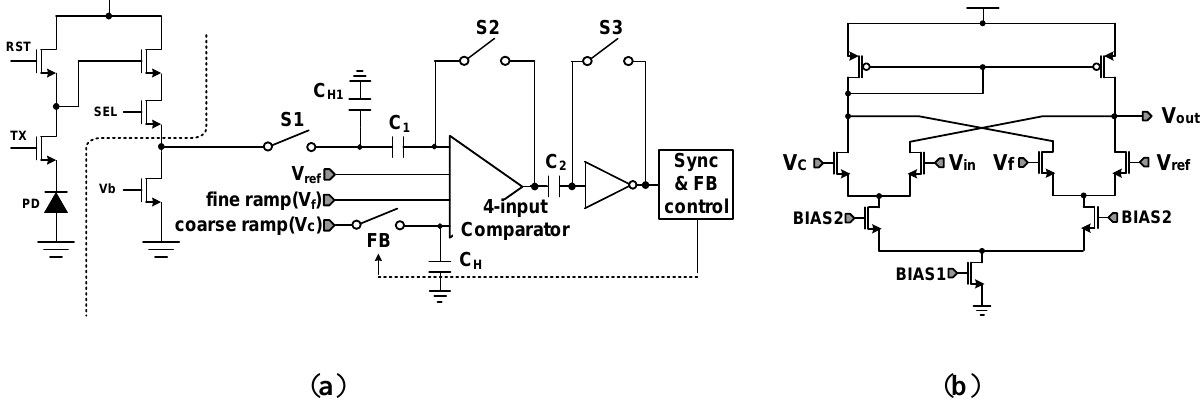
Figure 3. Circuit diagram for analog CDS with the proposed TS SS ADC: ( a ) analog CDS structure; ( b ) 4-input